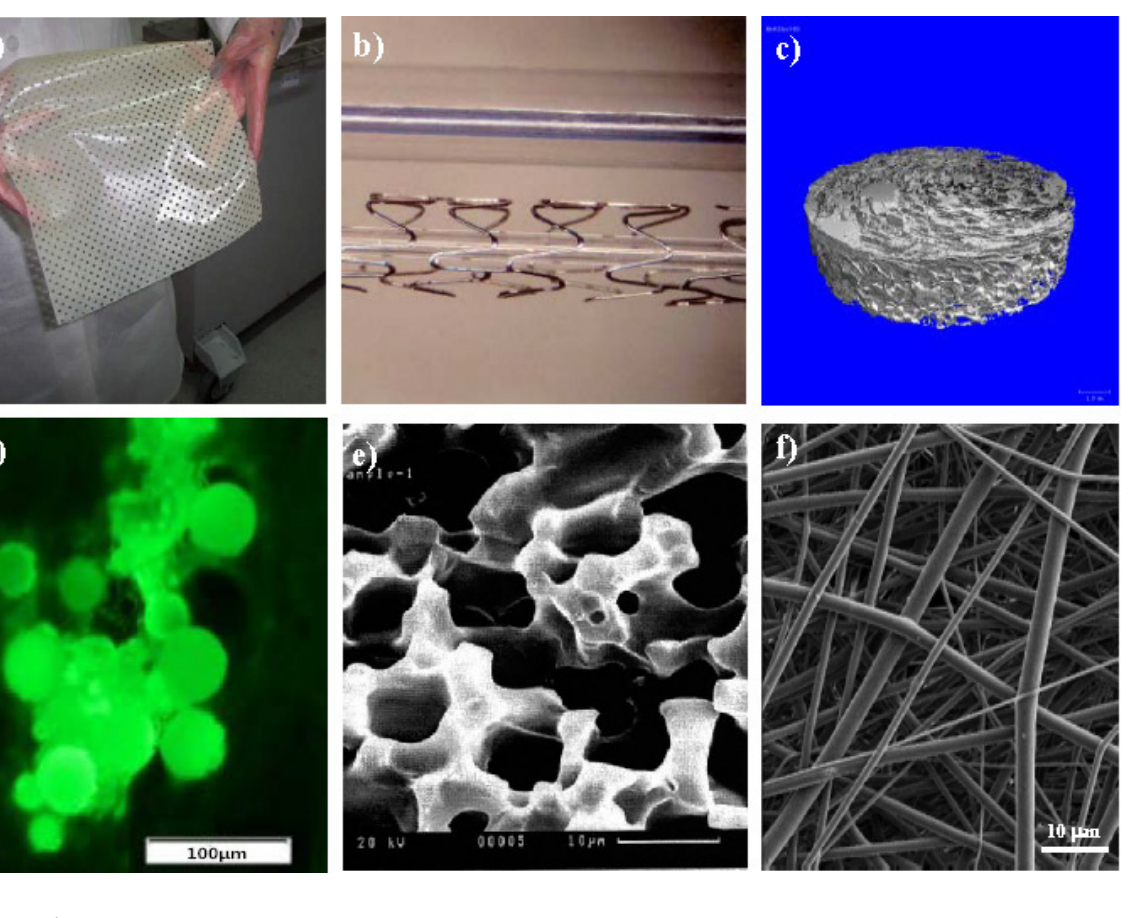
Figure 43. Some biomedical applications of AABBP as resorbable biomaterials: ( a ) an artificial skin PhagoBioDerm; ( b ) drug eluting vascular stent; ( c ) bone substitute; ( d ) microspheres for drug delivery; ( e ) porous scaffolds for cell cloning; ( f ) electrospun